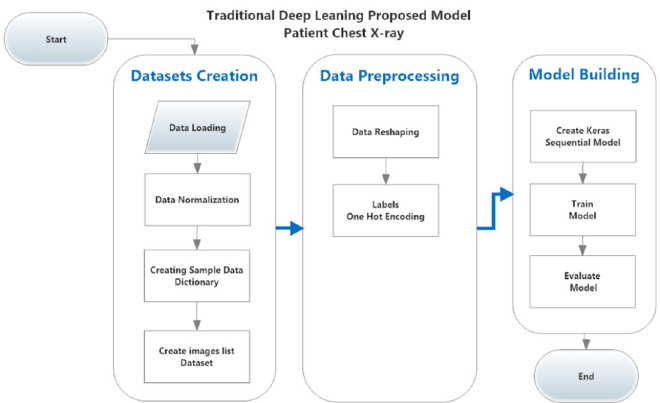
Fig 4. The proposed traditional model for classifying COVID-19 cases from chest x-ray images.